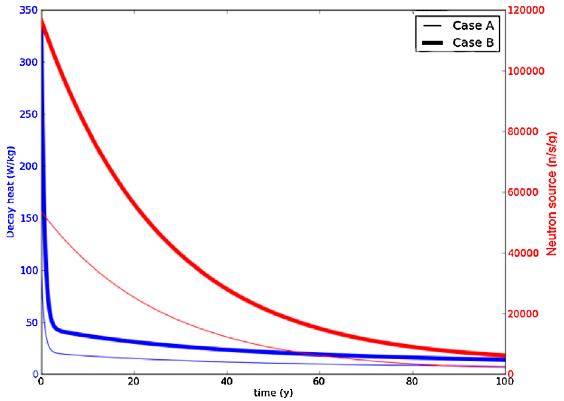
Fig. 5. Evolution of decay heat and neutron source versus cooling time.